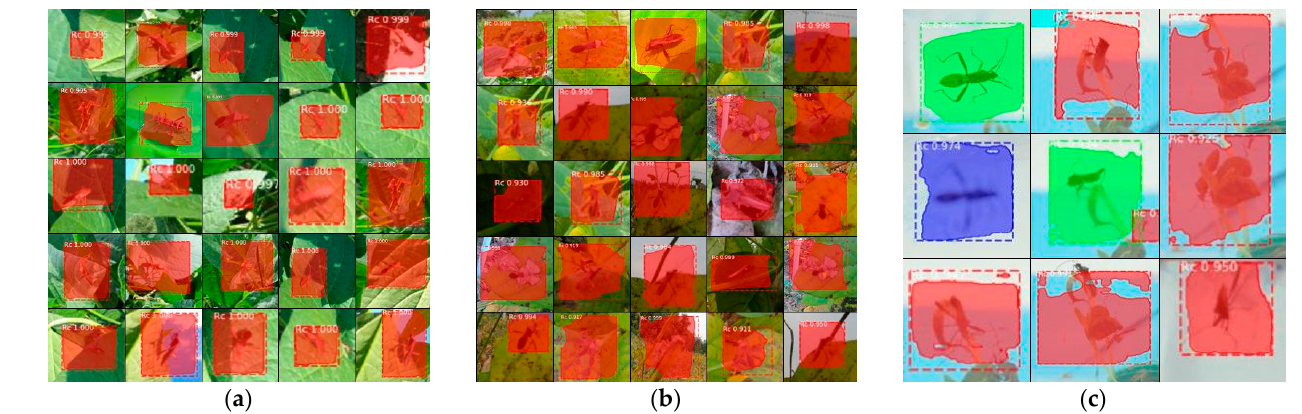
Figure 7. Detection feature map under each condition. As a result of detection, a mask and bounding box are applied to the objects one wants to be detected. When several objects are detected in one sample image, they are distinguished by different colors. ( a ) R. pedestris object detection feature map derived using samples from pod filling stages (R1 to R6) of soybean growth; ( b ) feature map using samples from maturity stages (R7 to R9); ( c ) the results from an artificial cage in the laboratory.